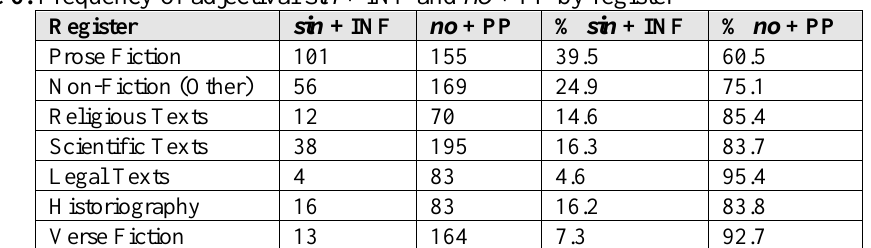
Table 6. Frequency of adjectival sin + INF and no + PP by